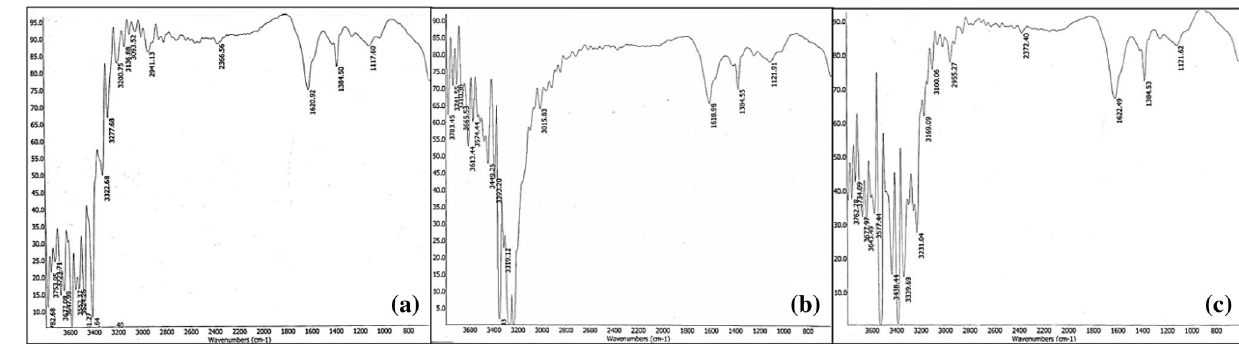
Fig. 2 FTIR spectra of virgin Fe-KWC ( a ) and Spent Fe-KWC after adsorption of Arsenic ( b ) and Fluoride ( c )